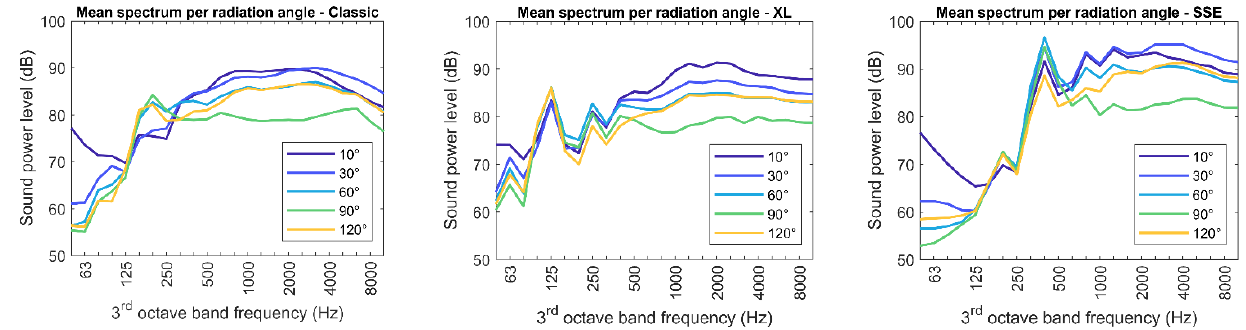
Figure 6. Sound power spectra in dependence of the radiation angle 𝜁 , for the three multicopters under evaluation.